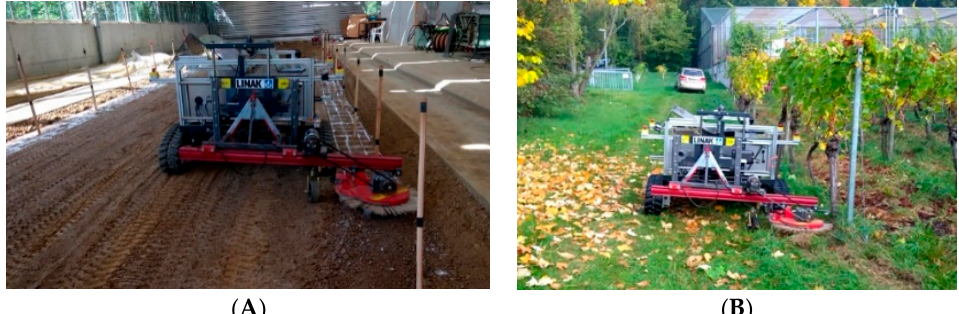
Figure 4. The two test environments– ( A ) indoor laboratory and ( B ) outdoor vineyard.